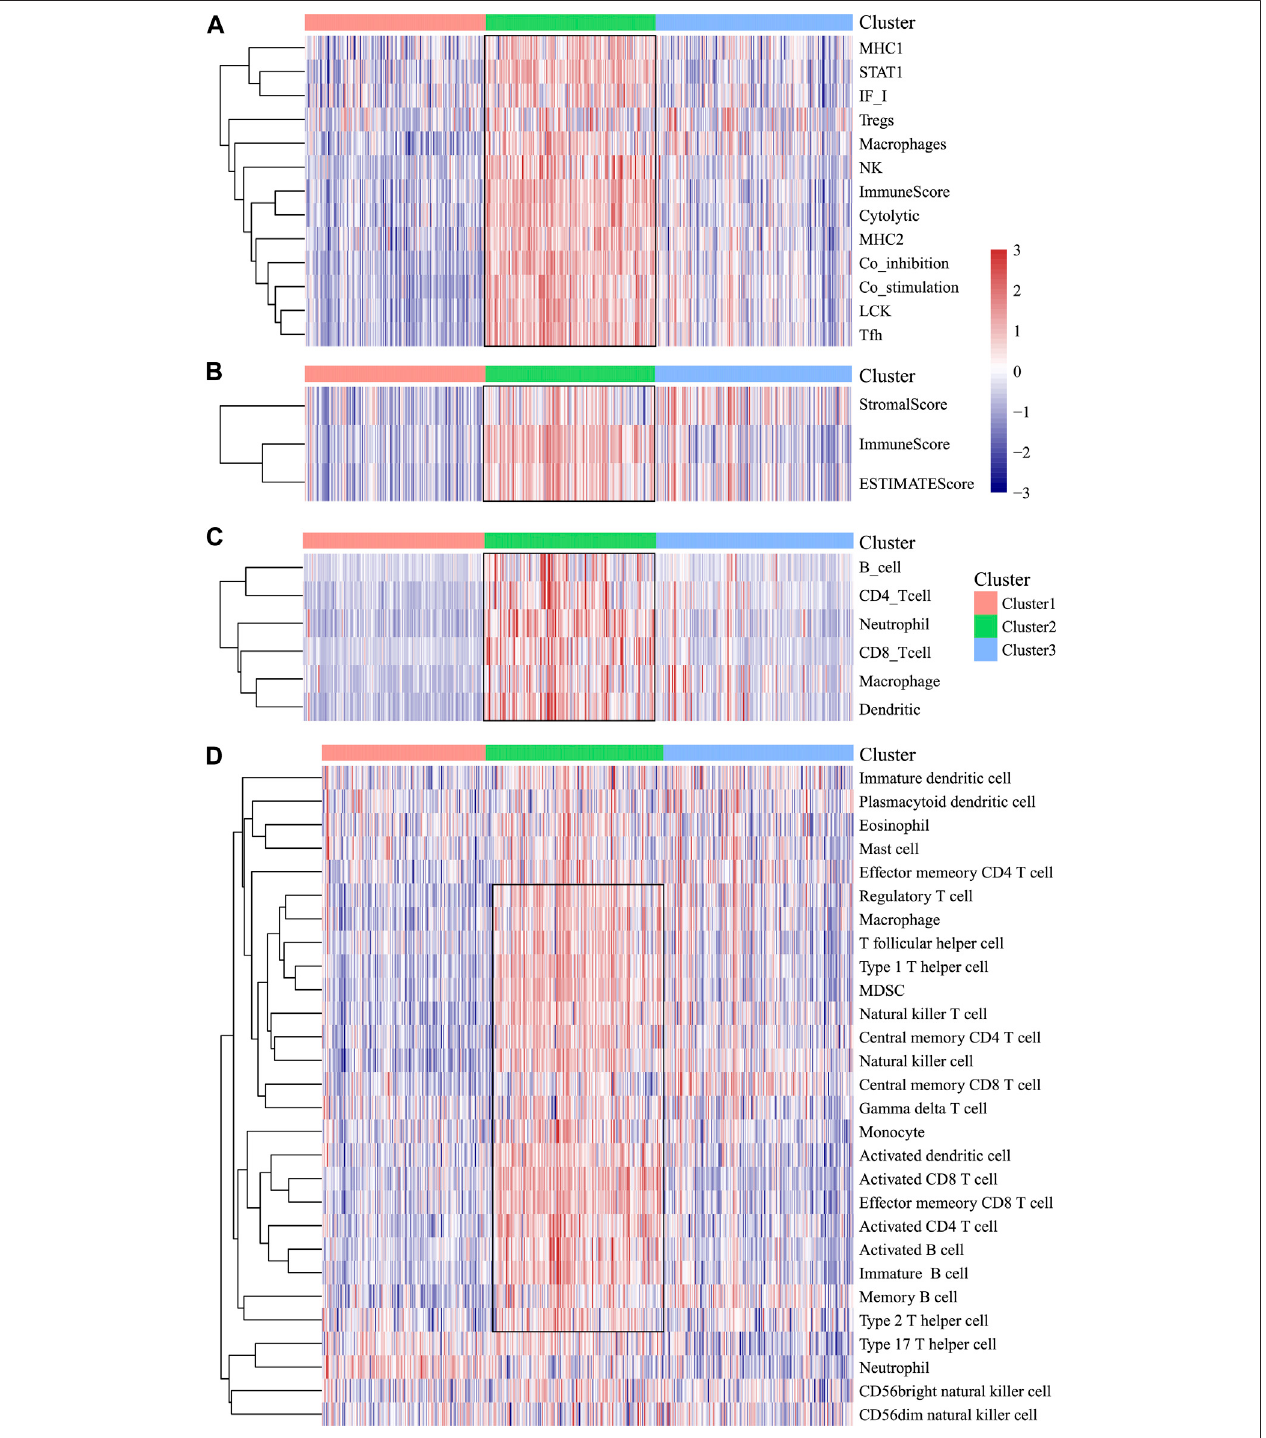
FIGURE 3 | Immune pro fi les of the three HNSCC subtypes in the TCGA cohort. (A) Scores of 13 types of immune metagenes in the three HNSCC subtypes are displayed. (B) Tumor stroma scores, the immune scores, and the ESTIMATE scores of the three HNSCC subtypes are displayed. (C) Scores of six types of immune in fi ltrating cells among the three HNSCC subtypes are shown. (D) Scores of 28 groups of immune related pathways across three subtypes are shown.